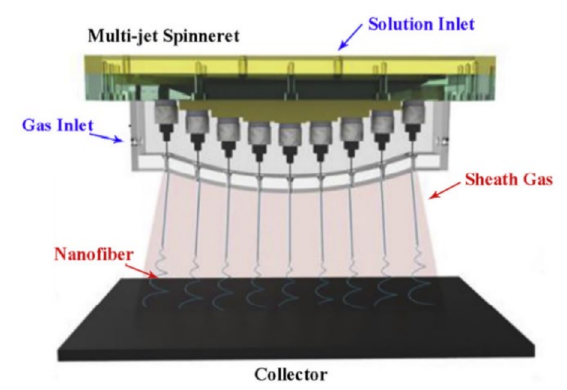
Figure 4. Schematic diagram of multi-jet electrospinning [12].